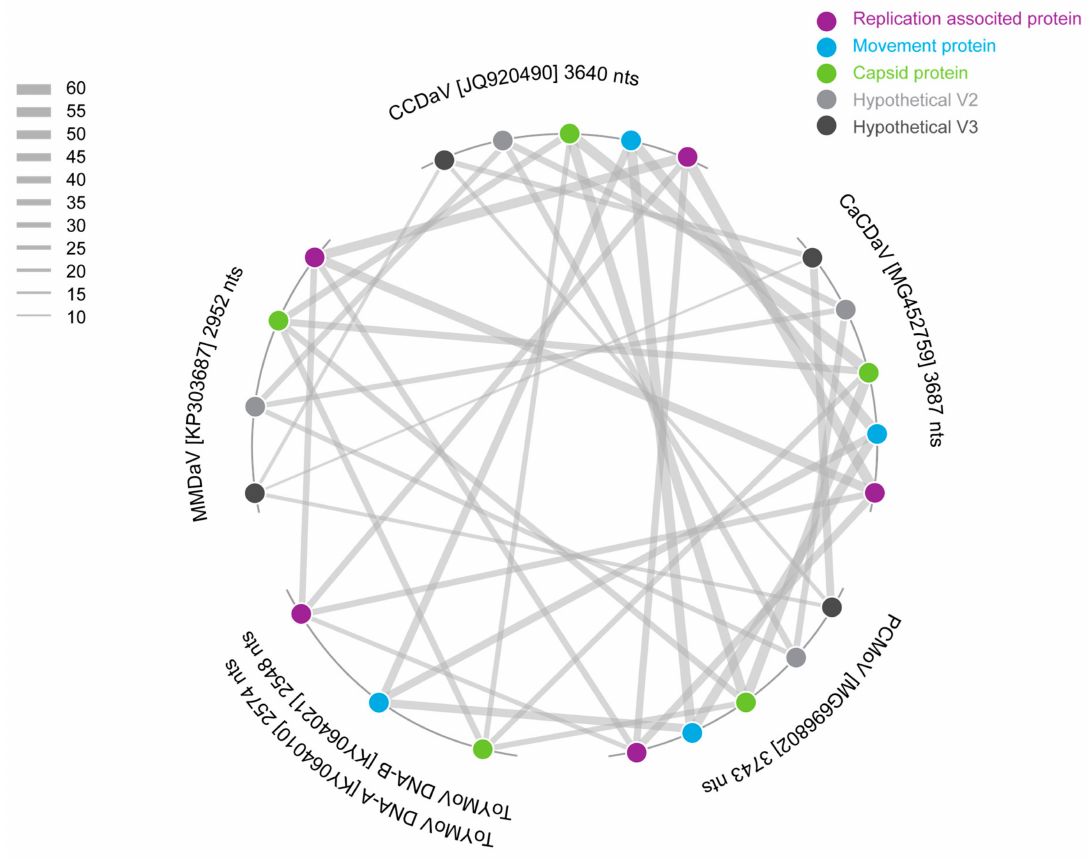
Figure 4. Pairwise identity comparison of the MP, CP, Rep, hypothetical V2 protein and V3 protein of PCMoV, CaCDaV, CCDaV, MMDaV, and